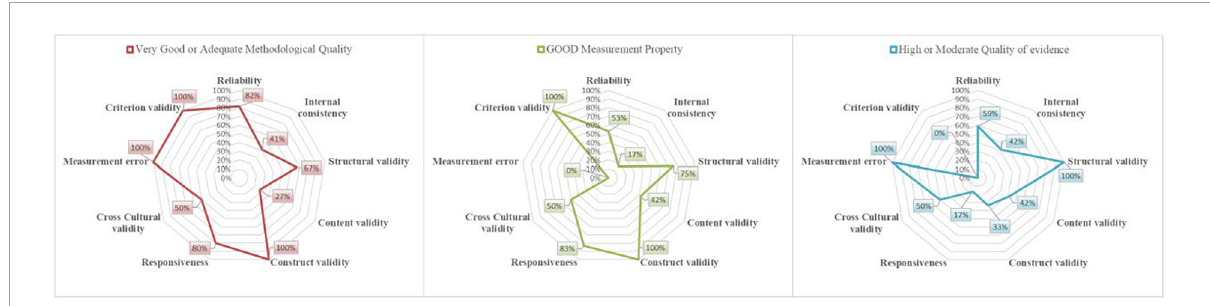
FIGURE2 Quality assessment. The assessed measurement properties of 19 NTS instruments to which the plotted lines refer, are distributed around the radar. The red line in the first chart plots the proportion of studies with a very good or adequate methodological quality, over a total of 26 studies. The green line in the second chart represents the proportion of instruments with good measurement properties. The blue line in the third chart shows the proportion of instruments with high or moderate evidence quality. For example, content validity was of very good or adequate methodological quality in 27% of the included articles (3/11 studies), instruments with good measurement properties of content validity were 42% (8/19 instruments) and instruments with high or moderate evidence quality of content validity were 42% (8/19